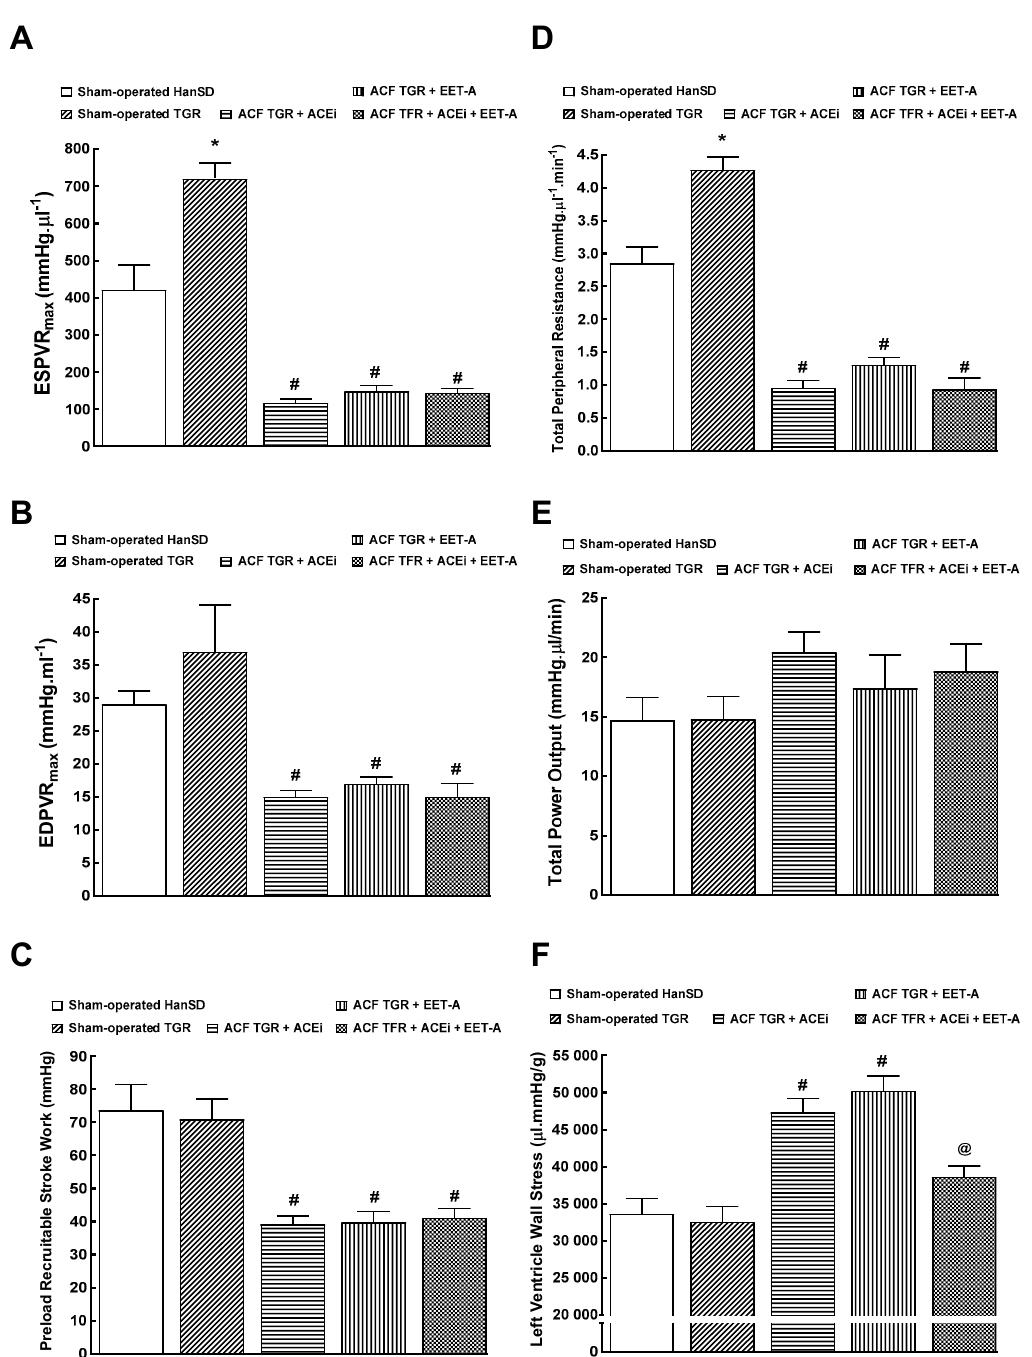
Figure 8. Part 2 of the left ventricular cardiac function assessment by invasive hemodynamic analysis performed 22 weeks after creation of the aorto-caval fistula (ACF) and 20 weeks after initiation of treatment in sham-operated transgene-negative Hannover Sprague-Dawley (HanSD), sham-operated heterozygous Ren-2 transgenic rats (TGR) and TGR rats with ACF, untreated or treated either with angiotensin-converting enzyme inhibitor (ACEi) alone or with 14,15-epoxyeicosatrienoic acid analog (EET-A) alone or with the combination of EET-A and ACEi. End-systolic pressure-volume relationship (ESPVR) ( A ), end-diastolic pressure-volume relationship (EDPVR) ( B ), preload recruitable stroke work ( C ), total peripheral resistance ( D ), total power output ( E ), left ventricular wall stress ( F ). * p < 0.05 sham-operated TGR versus sham-operated HanSD rats. # p < 0.05 for ACF TGR versus sham-operated TGR. @ p < 0.05 versus other ACF TGR.